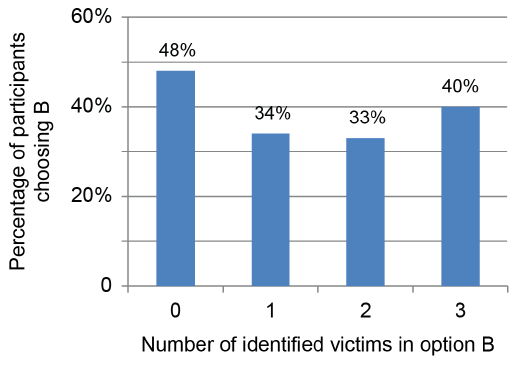
Figure 3. Preferences shifted when identified victims were presented in loss-of-life gambles.